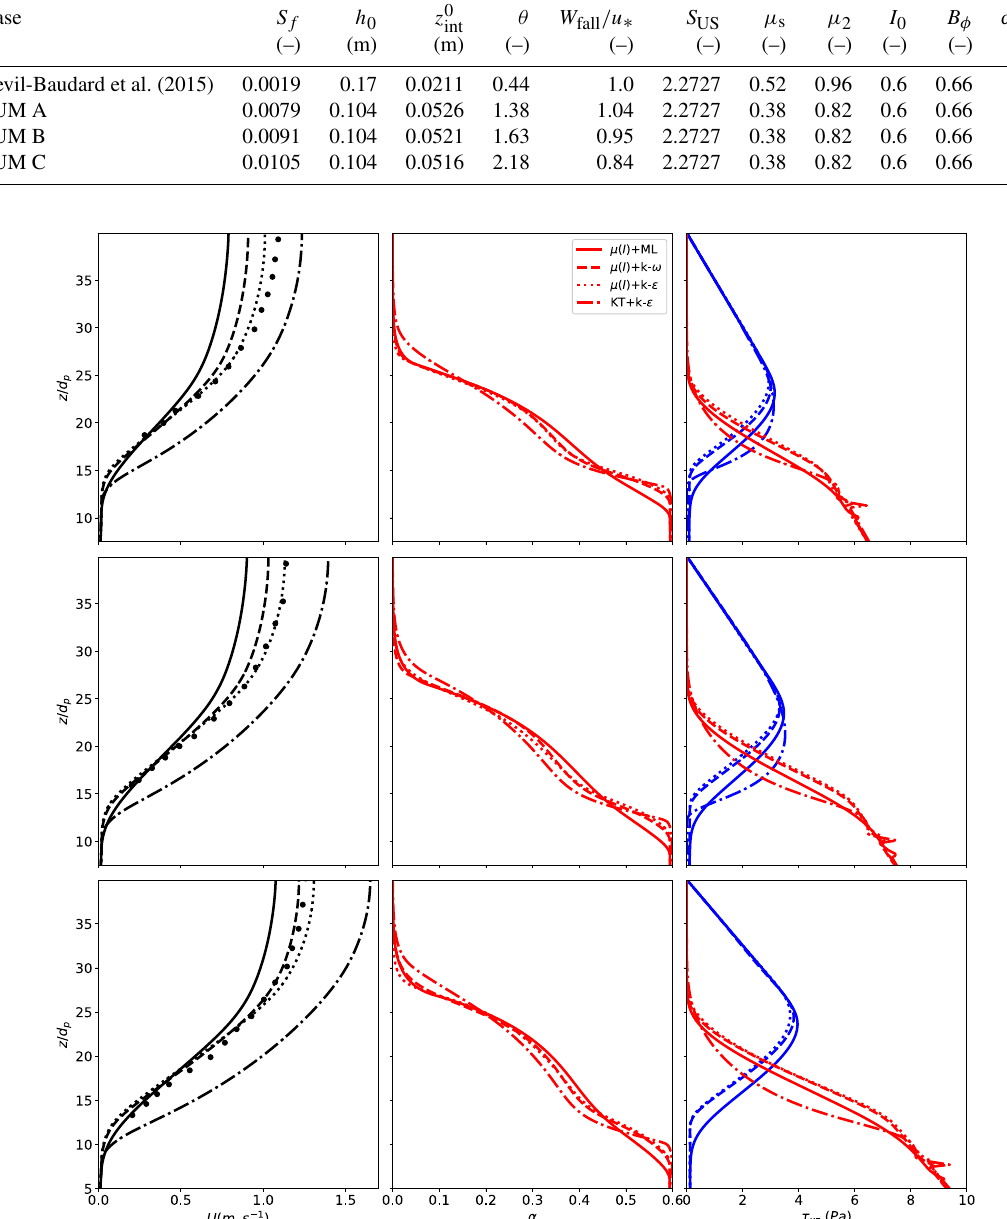
Figure 4. Comparison of two-phase numerical results with experiments of Sumer et al. (1996) (black symbols) in terms of volume-averaged velocity profiles (black lines) in the left column of panels, sediment concentration (red lines) in the center column of panels, and Reynolds shear stress (blue lines) and granular stress (red lines) in the right column of panels, using the dense granular-flow rheology ( µ(I) ) with the three turbulence models (mixing length, ML; k − ω ; and k − ε ) and the kinetic theory of granular flows with the k − ε turbulence model. The upper row of panels corresponds to the SUM A case, the middle row of panels corresponds to the SUM B case, and the bottom row of panels corresponds to the SUM C case. The values of the different numerical and physical parameters are reported in Table 9.